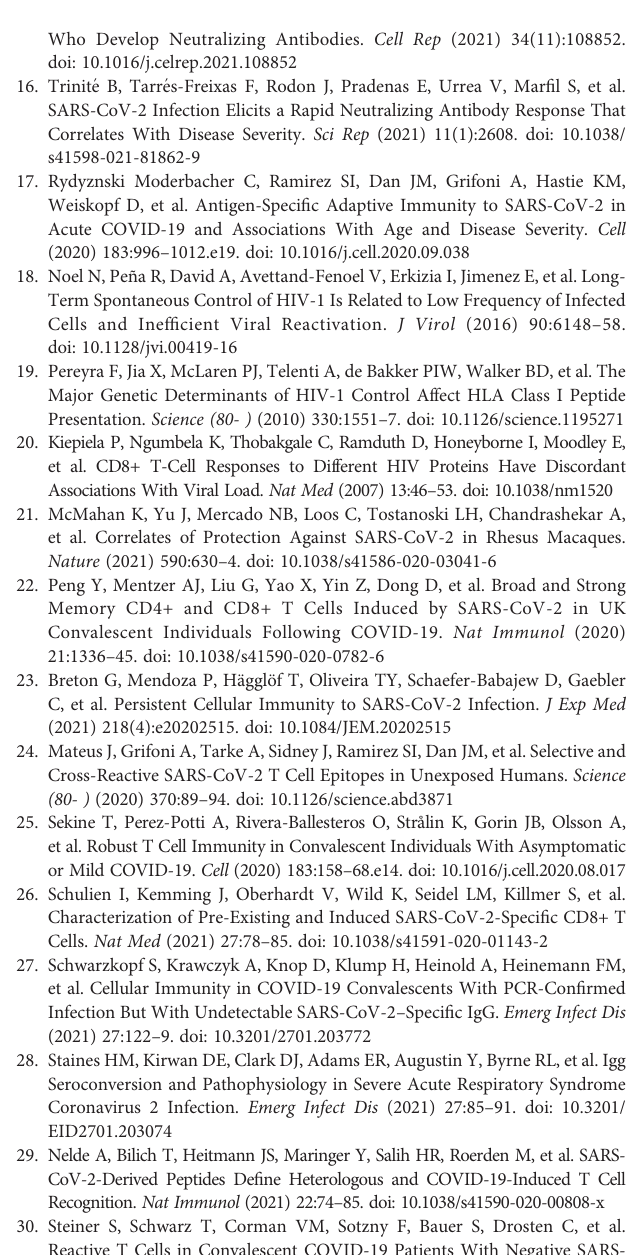
Supplementary Figure 3 | Proliferation in CD4+ and CD8+ T cells of Non- seroconvertors and seropositive individuals with severe disease. (A) Representative dot-plots summarizing CFSE loss in CD4+ and CD8+ T cells following stimulation with S and NP SARS-CoV-2 proteins in two NSC. Frequency of proliferating cells in NSC and seropositve individuals in response to S and NP antigens. Values from unstimulated cells were subtracted for each individual (B) . Supplementary Figure 4 | Cytokine expression in CD4+ and CD8+ T cells of Non-seroconvertors and seropositive individuals with severe disease. Single-cell analysis based on antigen expression (TNF, IL-2 and IFN- g intensity) using UMAP dimensionality reduction in CD4+ T-cells following stimulation with S (A) and NP (B) as well as CD8+ T cells stimulated with S (C) and NP (D)